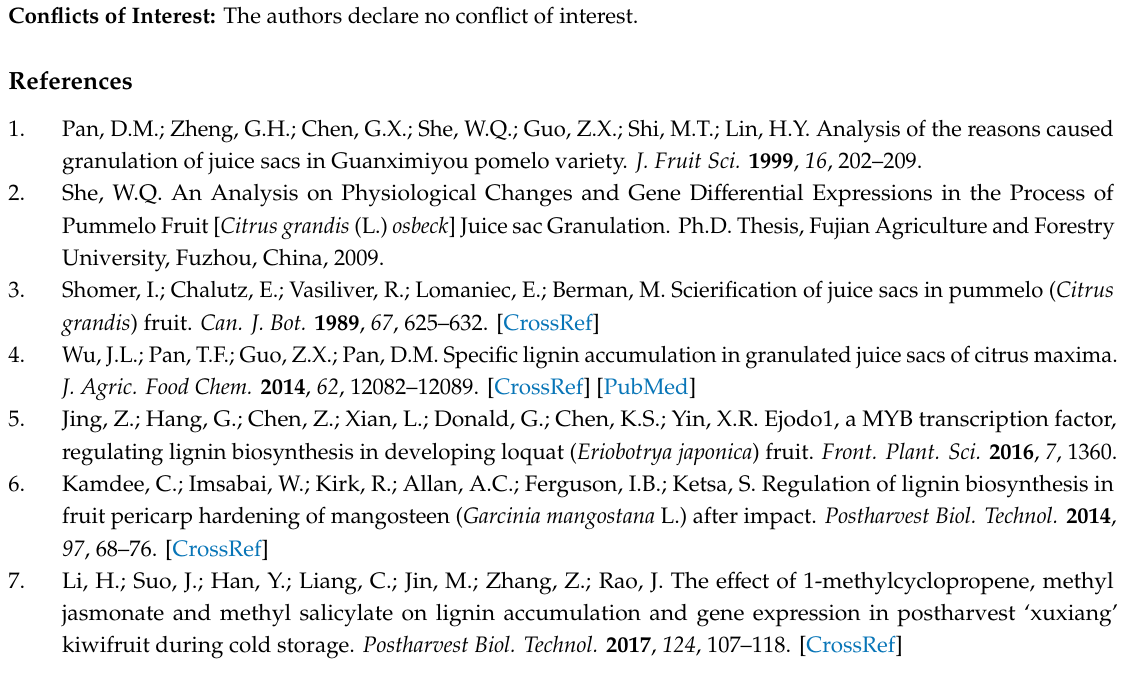
Supplementary Materials: The following are available online at www.mdpi.com/xxx/s1, Table S1: Correlation between ATP, sugars, and related enzymes with lignin in pericarp of BR. Table S2: Correlation between invertases with sucrose in pericarp of BR.